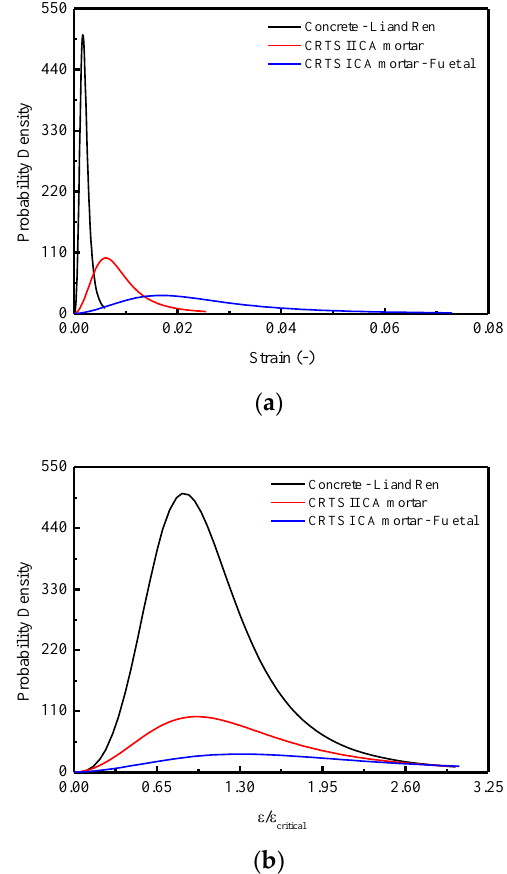
Figure 18. Comparisons of the mean constitutive relationships among CRTS II CA mortar, CRTS I CA mortar, and concrete under compression in terms of: ( a ) Probability density— 𝜀 curve; ( b ) Probability density— 𝜀 / 𝜀 𝑐𝑟𝑖𝑡𝑖𝑐𝑎𝑙 curve.